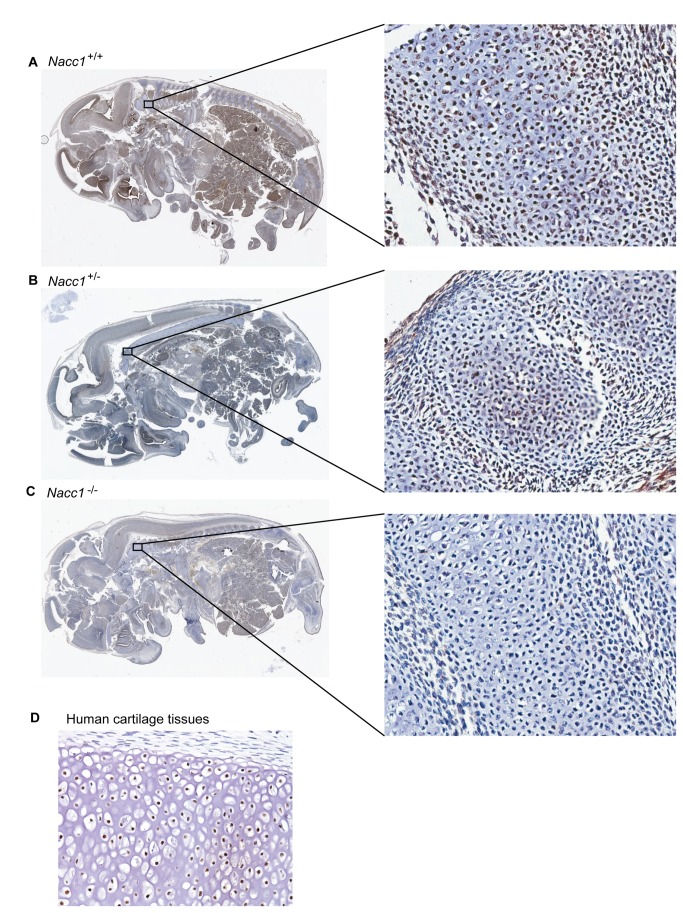
NAC1 expression in the chondrocytes of wild type mouse embryos. Comparison of representative para-sagittal sections of Nacc1+/+ (wild type, A), Nacc1+/- (heterozygous, B), and Nacc1-/- (knockout, C) mouse embryos at embryonic day 16 (E16) shows the widespread distribution of NAC1 in various tissues, including chondrocytes (boxed regions). The wild type expression pattern exhibits widespread immunoreactivity including such axial tissues as vertebral primordia and the peri-ventricular germinal zones in the brain. D. Chondrocytes in cartilaginous tissues of a human embryo (estimated gestational age, 7 weeks) also exhibit extensive NAC1 immunoreactivity. Anti-NAC1 immunohistochemistry (using species-specific primary antibodies) with hematoxylin as the counterstain.